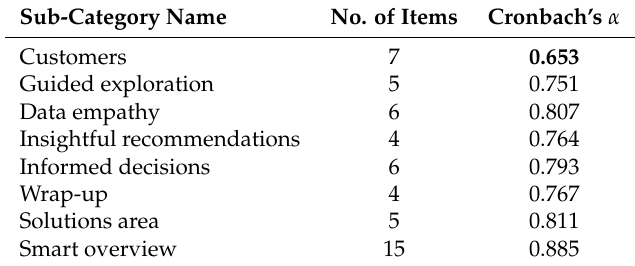
Figure 6. The on-line environment consisting of the various hierarchies of EUREKATAX. Table 1. Reliability alpha values of EUREKATAX